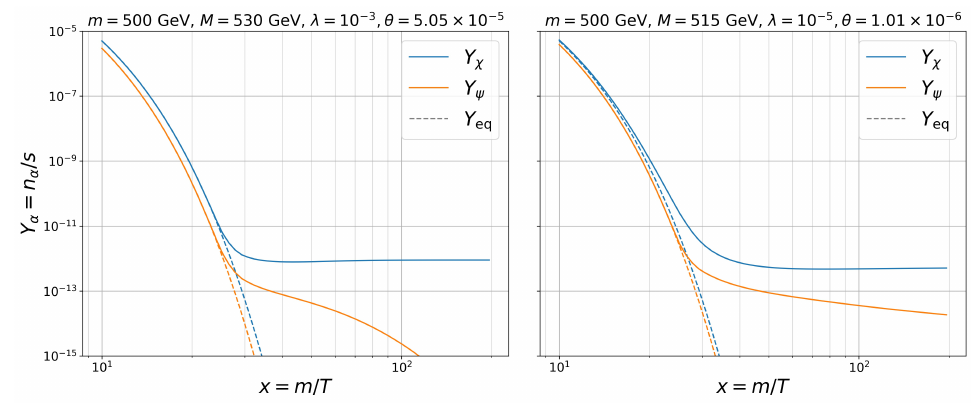
Figure 3: Evolution of the χ and ψ abundances for λ = 10 − 3 (left) and λ = 10 − 5 (right); The χ mass parameter is set to m = 500 GeV, while M is adjusted to obtain Ω h 2 ≃